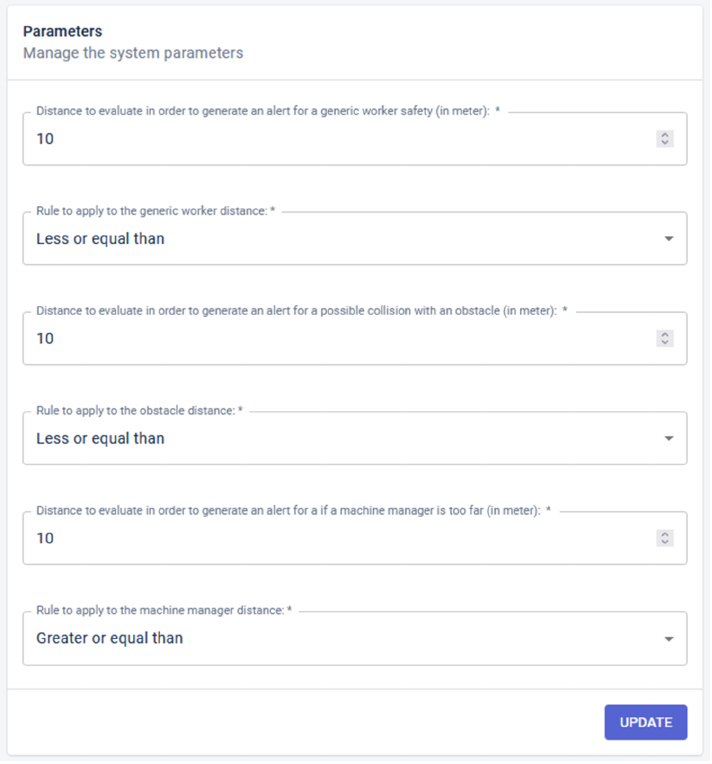
Figure 18. Settings tab of the Front-end